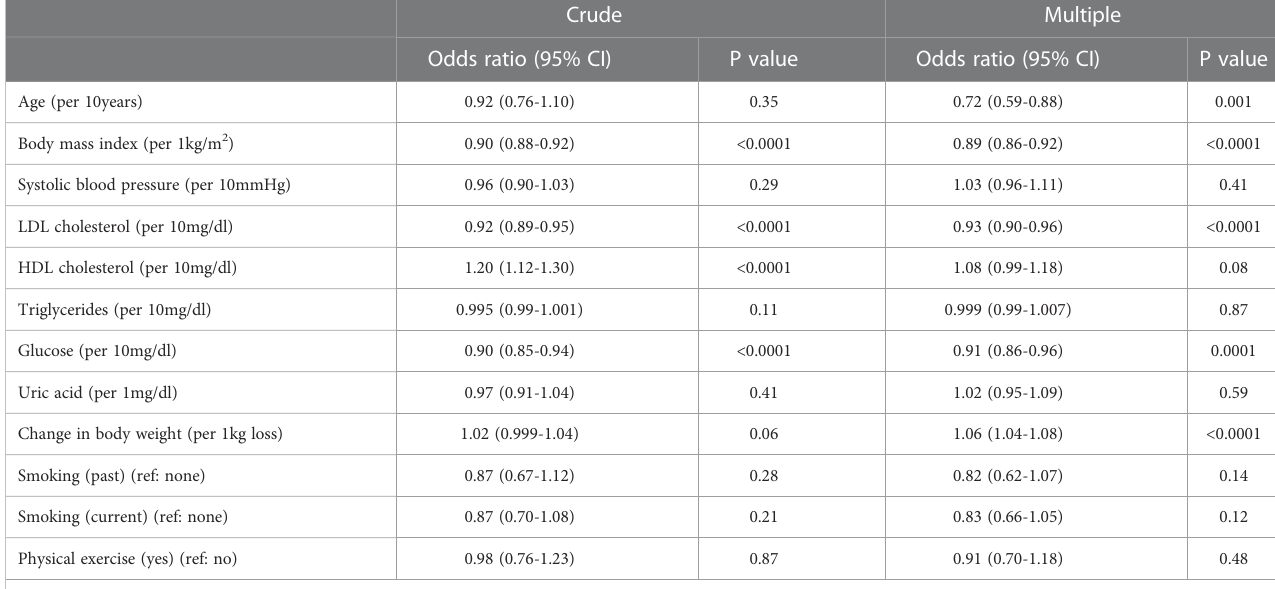
TABLE 2 Unadjusted and adjusted odds ratios for type 2 diabetes remission.